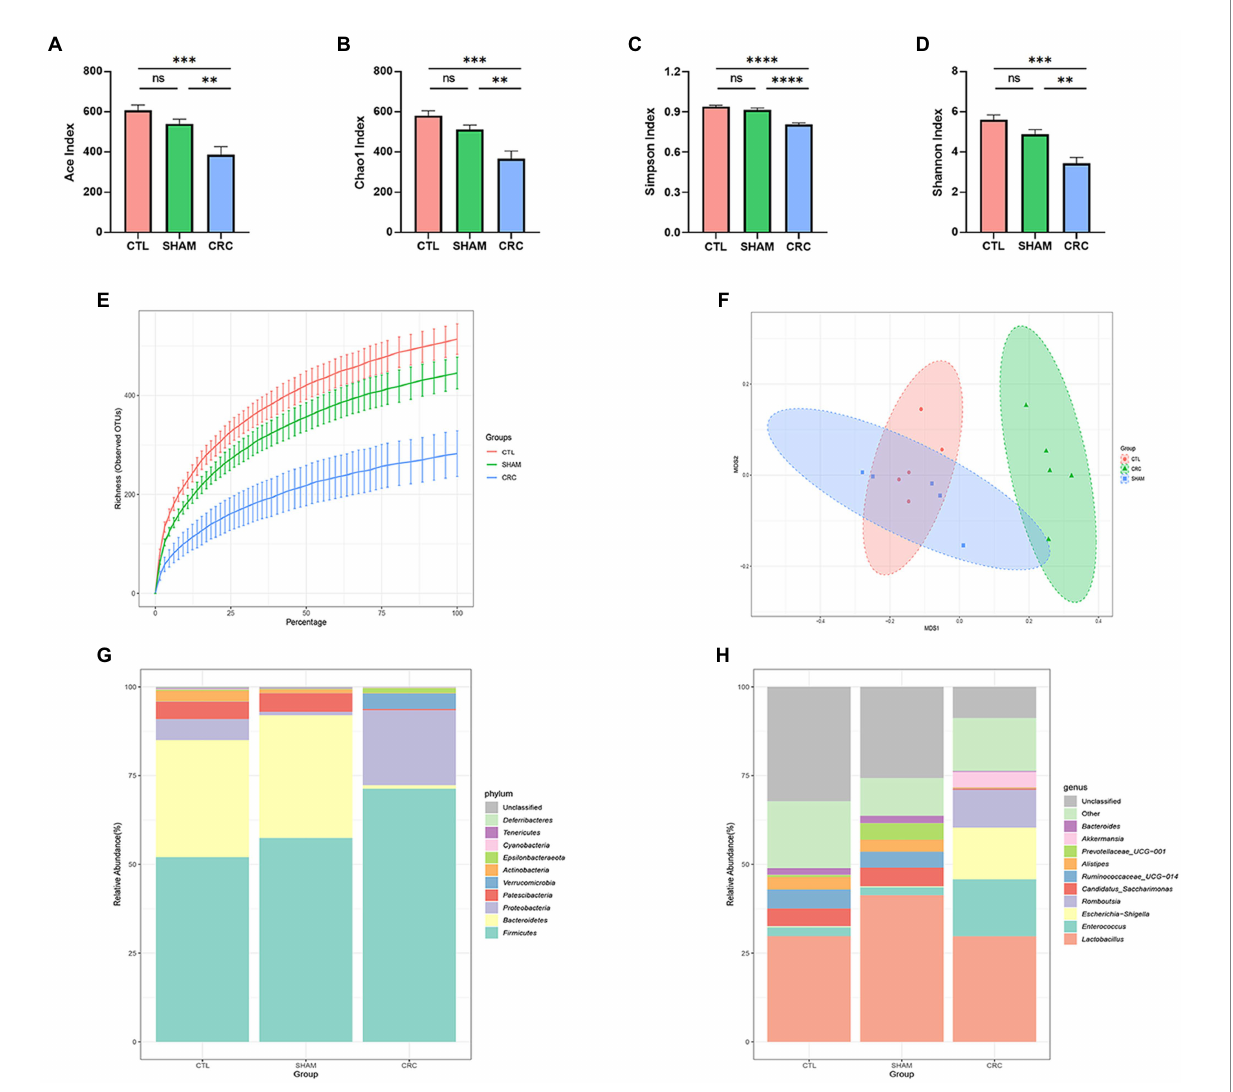
FIGURE 2 Decreased abundance of intestinal microbiota in CRC mice. Alpha diversity analysis of the three groups: Ace index (A) , Chao1 index (B) , Simpson index (C) , Shannon index (D) , and the richness dilution curve (E) . (F) Non-metric multidimensional scaling (NMDS) based on the operational taxonomic units (OTUs) in the three groups. Each point on the graph represents a sample. (G,H) Structural changes in the intestinal microbiota of the CRC model mice. The relative abundance of the top 10 microbial taxa was assessed at the (G) phylum and (H) generic levels. Data are mean ± SEM; n = 5, “ns,” not significant, ** p < 0.005, *** p < 0.0005, and **** p <